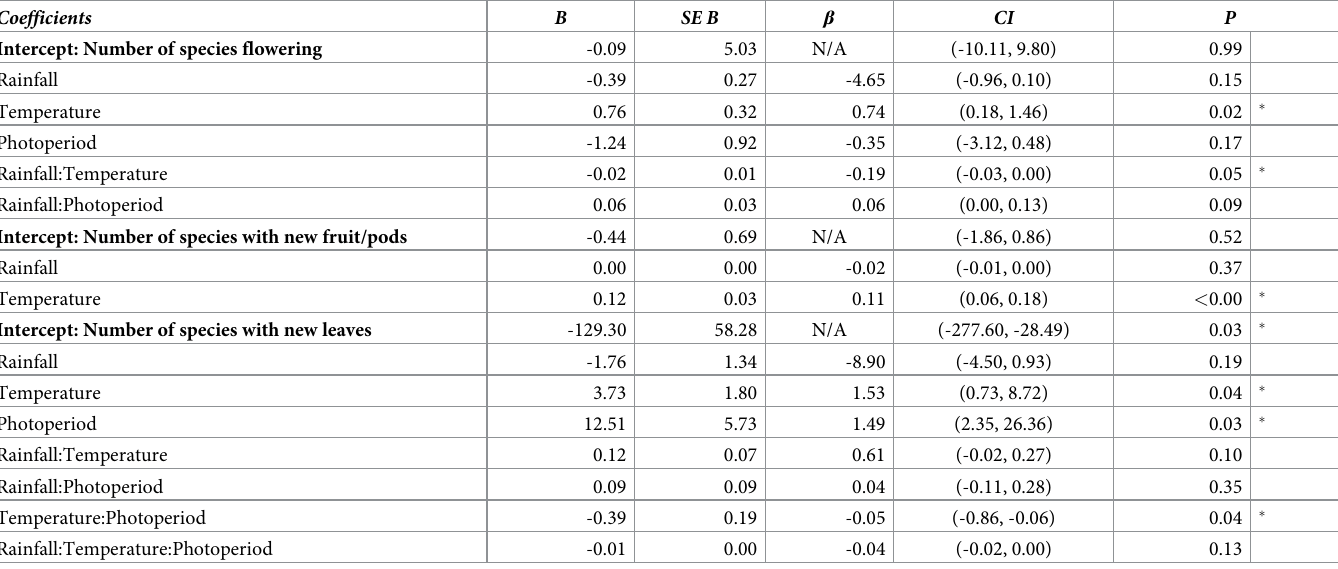
Table 2. Results for the minimum adequate models for a series of general linear models run to determine the effects of rainfall, temperature and photoperiod on the number of woody plant species flowering, with new fruit/pods and with new